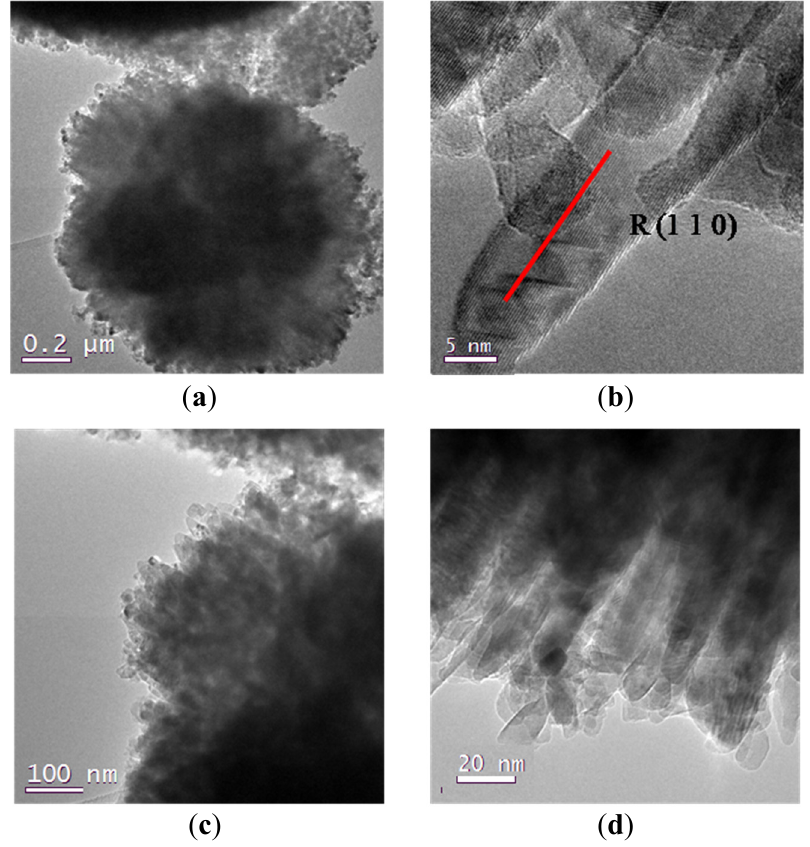
Figure 4. ( a ) TEM images of sample 7; ( b ) detail at high resolutions for sample 7; ( c ) TEM image of sample 8; ( d ) detail at high resolution for sample